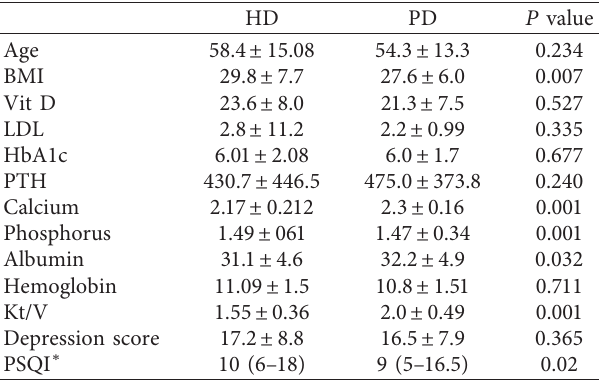
Table 3: Comparison between patients with different dialysis modalities based on different parameters.